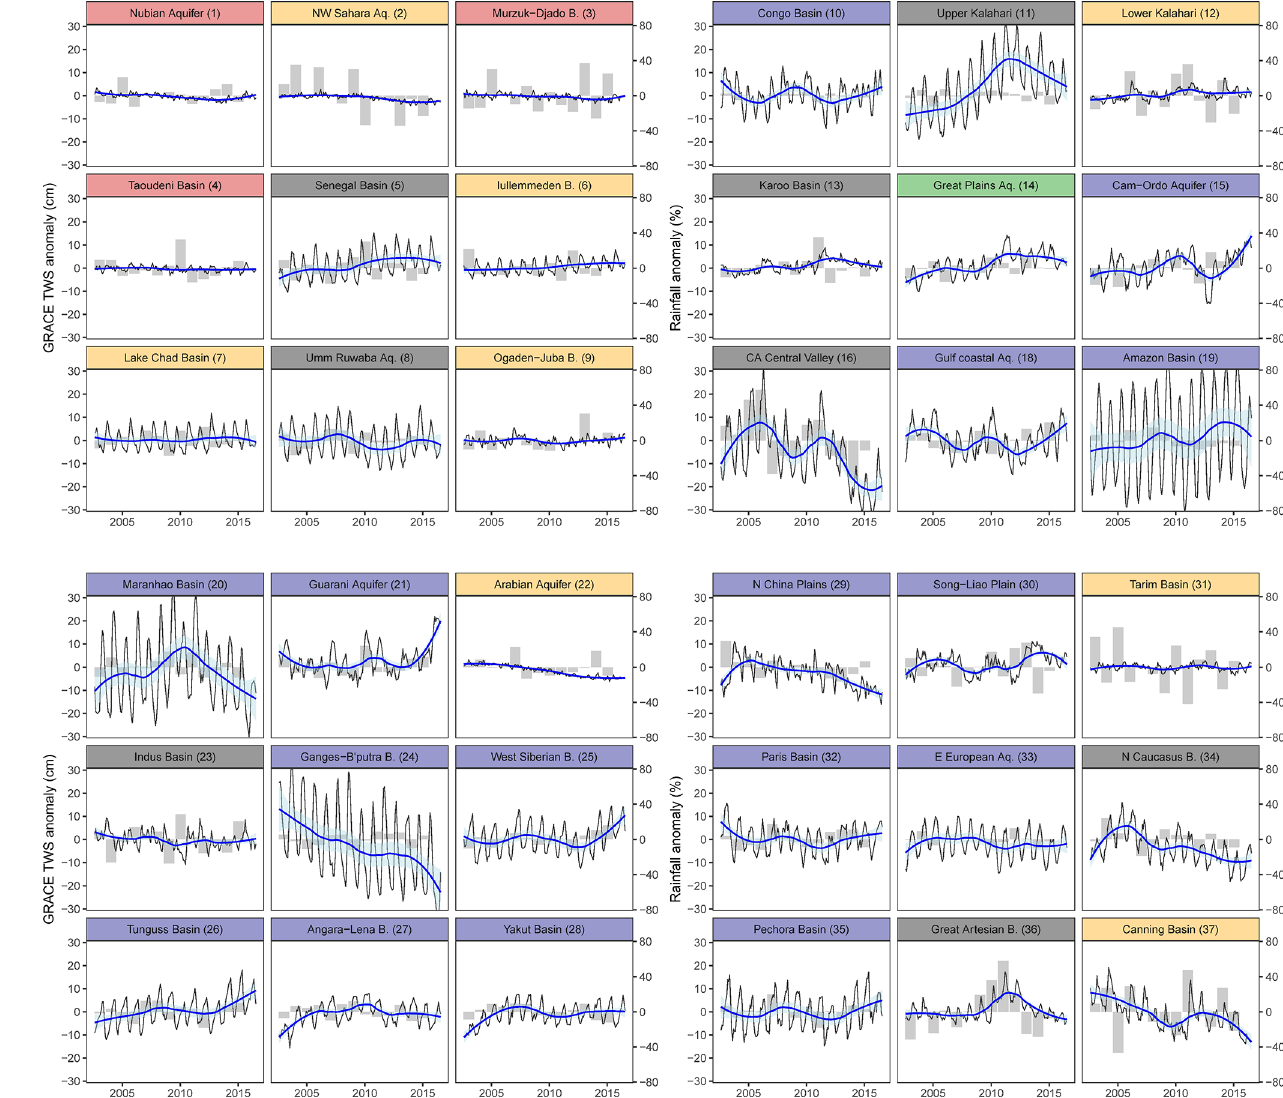
Figure 4. Monthly time series data (black) on ensemble GRACE (cid:49) TWS for 36 large aquifer systems with a fitted non-linear trend line (Loess smoothing line in thick blue) through the time series data; GRACE (cid:49) TWS for the remaining large aquifer system (High Plains Aquifer System, WHYMAP aquifer no. 17) is given in Fig. 2. The shaded area in semi-transparent cyan shows the range of the 95% confidence interval of the fitted Loess-based non-linear trends; light grey bar diagrams behind the lines on each panel show the annual precipitation anomaly (i.e. percentage deviation from the mean precipitation for the period of 1901 to 2016); banner colours indicate the dominant climate of each aquifer based on the mean aridity index shown in the legend in Fig.